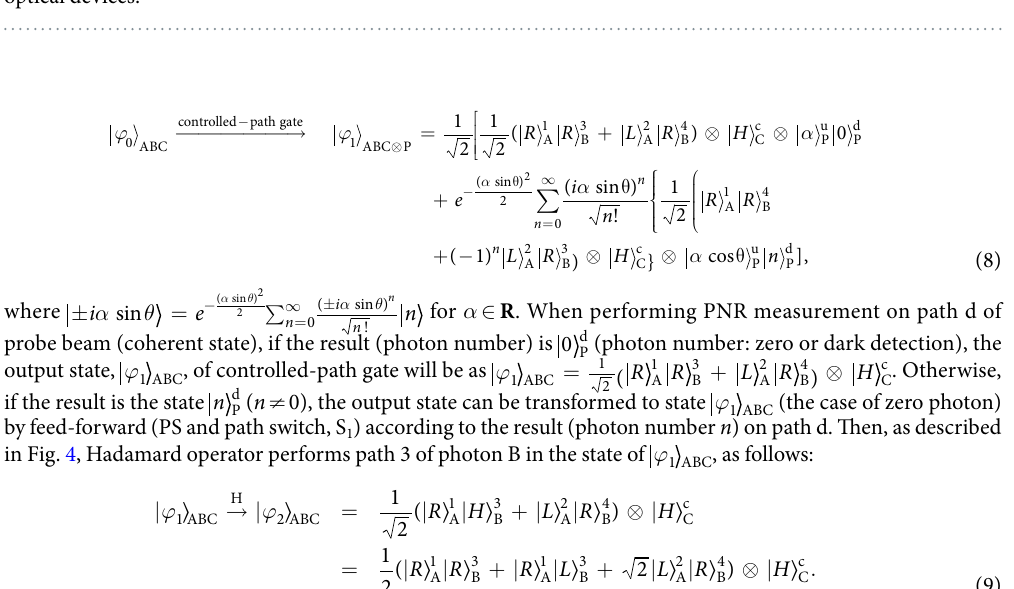
Figure 3. In our proposed scheme (generation of three-photon W state), critical components are nonlinearly optical (controlled and parity operations) gates using XKNLs and the QD-cavity system. Two controlled-unitary (controlled-Hadamard and CNOT) gates consist of weak XKNLs, qubus beams, and PNR measurements. Also, a QD within a single-sided optical cavity (the QD-cavity system) plays a role of parity operation which is implemented by the interaction between photons and a QD. Our scheme can generate three-photon entangled W state (final state) from three-photon product state (initial state) via nonlinearly optical gates and linear optical